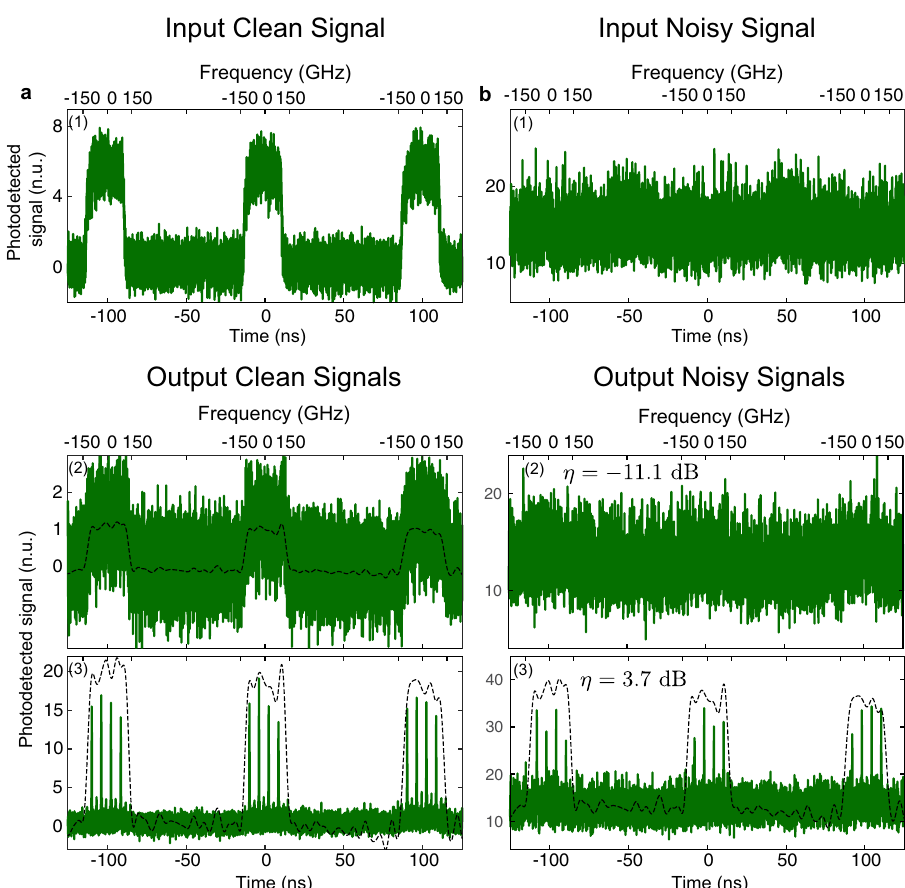
Fig. 3 Real-time recovery of spectral waveforms undergoing an S-TAI process. By using real-time optical Fourier transformation (RT-OFT) via dispersive propagation, the spectra of interest were directly mapped into the time domain, such that they could be detected on the fl y using a photodiode connected to a real-time oscilloscope (see “ Methods ” ). The measurements are shown in green, and a digitally fi ltered and scaled version of the SUT spectrum is shown in each case (dashed black) to facilitate a direct comparison with the recovered waveform. All waveforms are normalized to the peak value of the output signal with the phase modulation turned off. a (1) A waveform with a relatively high visibility is fi rst generated, and (2) the waveform is attenuated by the insertion loss of the S-TAI processing system, as observed by measuring the waveform at the output of the S-TAI system with the phase modulation off. (3) Activating the phase modulation leads to the formation of spectral peaks, recovering an accurate representation of the initial signal spectrum directly along the time domain (i.e., in real time). b Similarly, when the waveform has a low visibility (buried under noise), RT-OFT of the signal at the output of the S-TAI is also able to recover the information of the initial waveform, in a real-time and single-shot